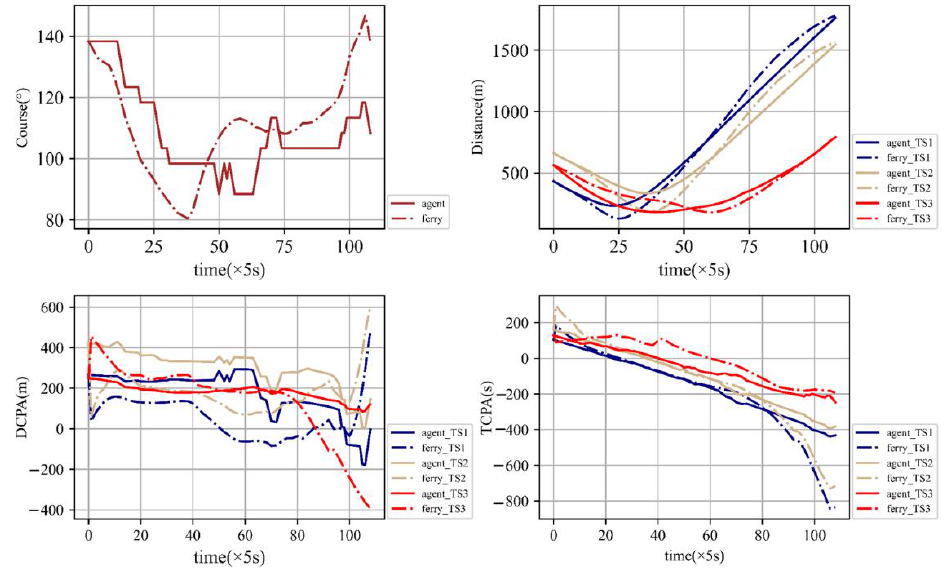
Figure 13. Course, relative distance, DCPA and TCPA.